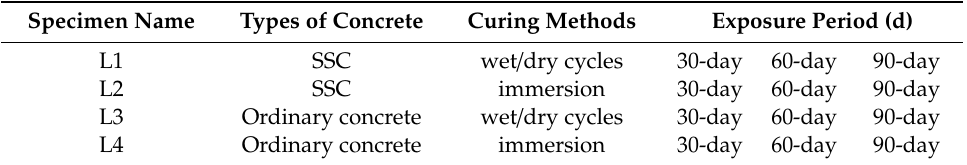
Table 2. Grouping of reinforced concrete sample.